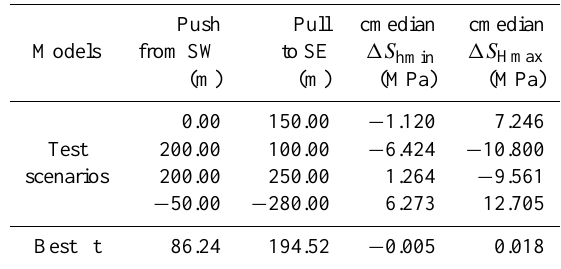
Table 2. Overview of major push-and-pull experiments. The orien- tation of the displacement boundary condition is indicated in Fig. 4. Four test scenarios with different push and pull magnitudes are dis- played, same as in Fig. 15a and b. The displacement boundary con- ditions for the best-fit model (last line) are calculated based on bi- variate linear regression; see